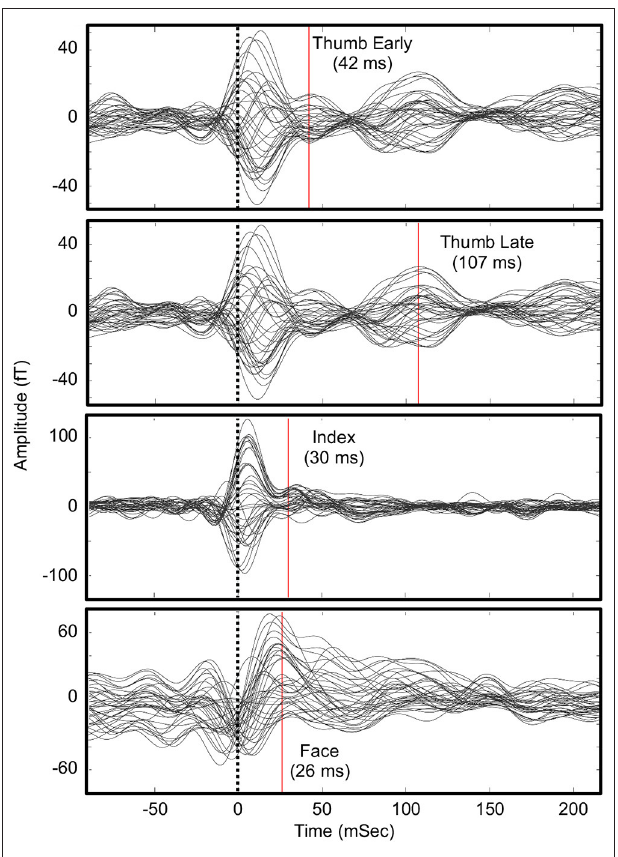
FIGURE 1 | Waveforms for somatosensory evoked fields in the parietal lobe sensors. Times of source analysis are indicated by the red line. An early